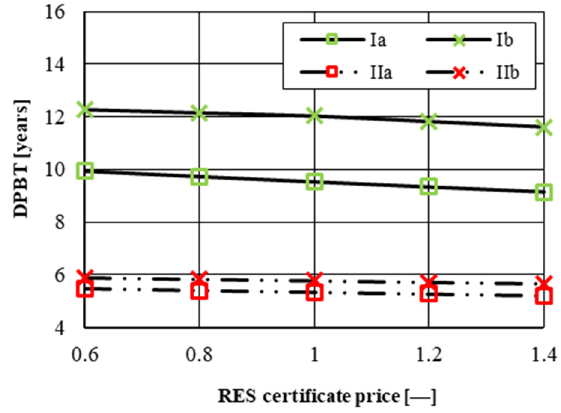
Figure 10. Dependence DPBT to relative RES certificate price.